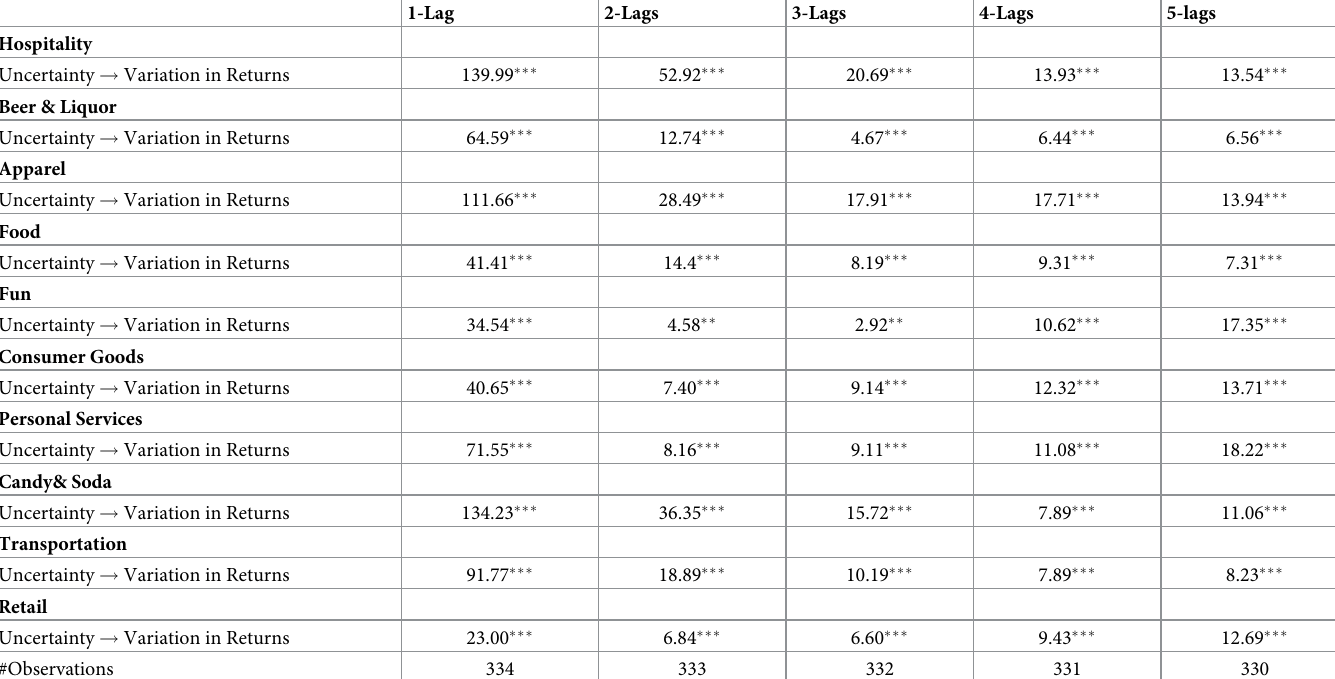
Table 4. Granger causality test results (December 31, 2018-April, 30,